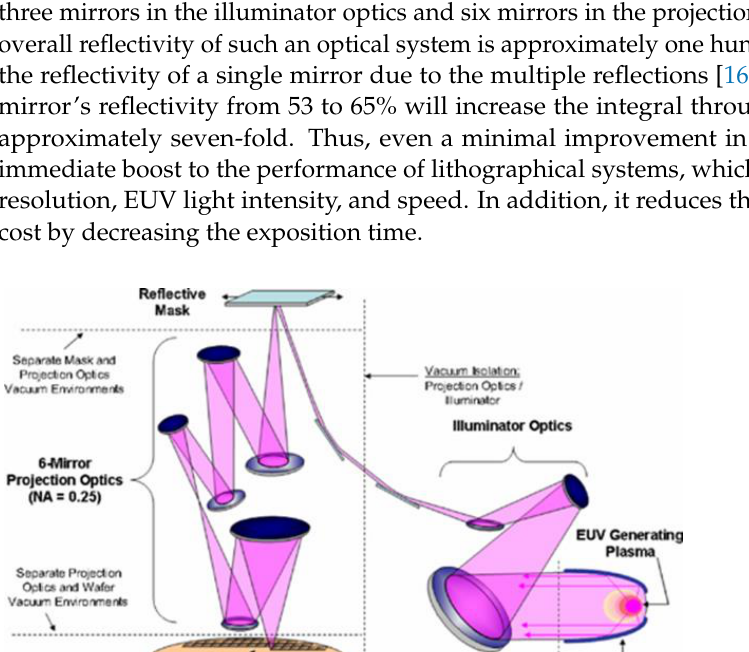
Figure 2. Schematics of the optical system of a lithographical stepper machine. Reprinted from [15]. The weak reflection of soft X-ray radiation by solids demands advanced reflective op- tical equipment. Immediately after the discovery of X-rays, it was stated that the refractive index of all materials is very small ( ∼ 10 − 5 ) [18]. Later, by discovering X-ray diffraction from crystals, the method of deflecting X-rays was provided for the first time [18]. A